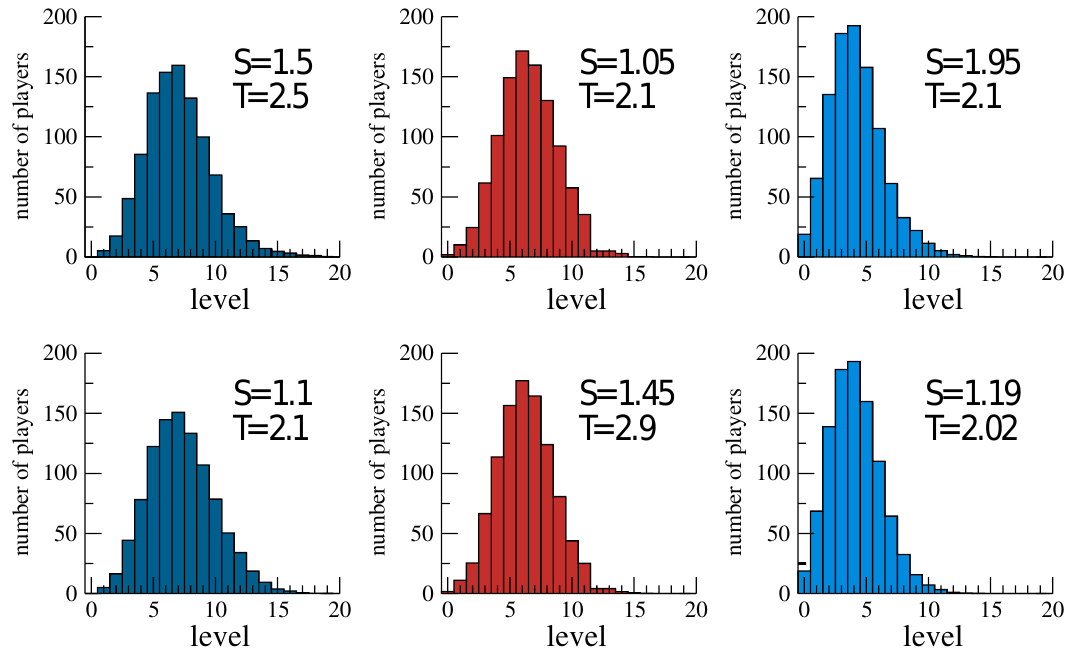
Figure 5. Histograms of the cognitive levels of the population in the stationary state of the dynamics of the SG game in Scenario C. Panels in the same vertical correspond to games in the same equivalence class m . The values of the game parameters T and S are shown inside the corresponding panel.